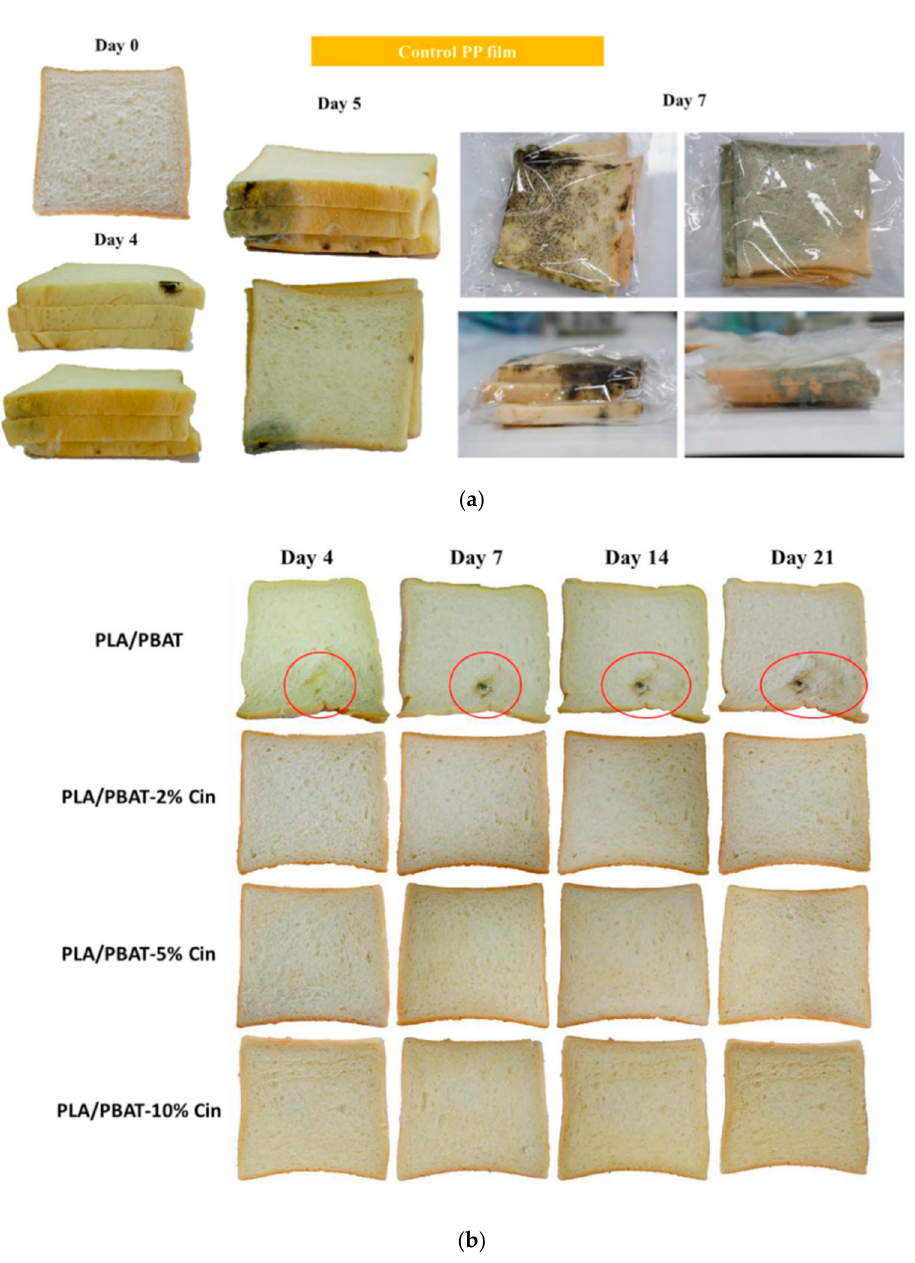
Figure 7. Appearance of packaged bread stored in ( a ) PP and ( b ) PLA and PBAT blend films with different concentrations of transcinnamaldehyde (2%, 5% and 10%) for 21 days at 25 °C. Circles indicate mold growth on bread Reprinted with permission from ref. [134]. Copyright. 2020 Elsevier